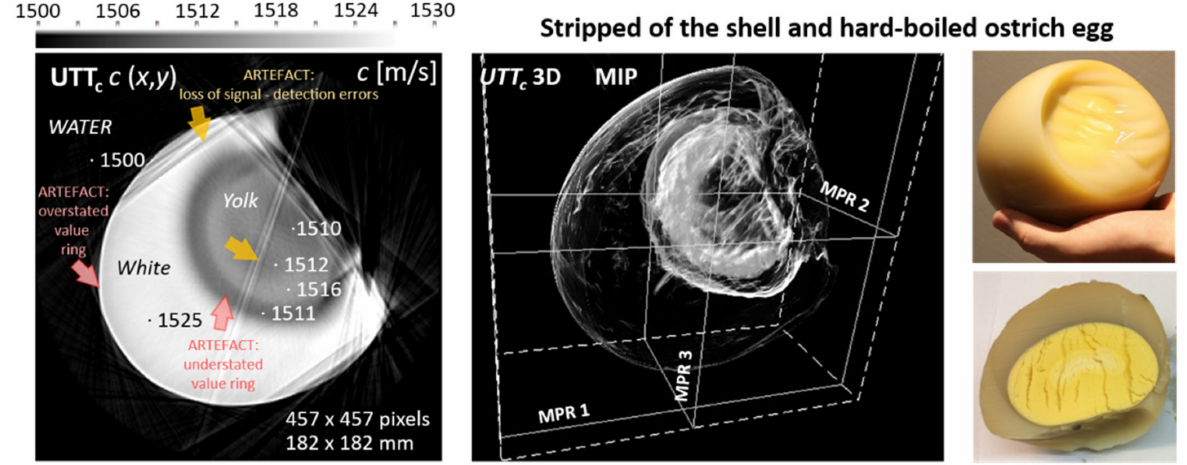
Figure 4. Artefacts in the example of reconstruction of ultrasound velocity distribution image in the cross-section of an ostrich egg measured with the prototype of the hybrid UBT